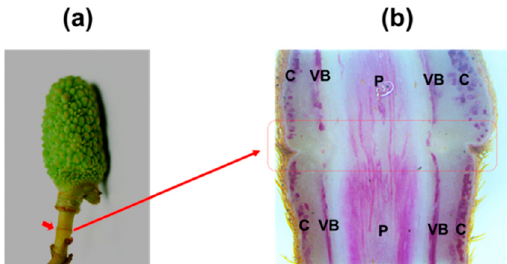
Figure 2. Lignin deposition within the peduncle abscission zone (AZ) in Litchi. ( a ) Fruitlet at 25 days after anthesis. Red arrow indicates the peduncle AZ. ( b ) Lignified cells within peduncle stained with phloroglucinol-hydrogen chloride (HCl). The red box indicates the AZ. Note that the interruption of lignified cells in the cortex, and reduced lignified cells in the pith region. C: Cortex; VB: Vascular bundle; P: Pith region.